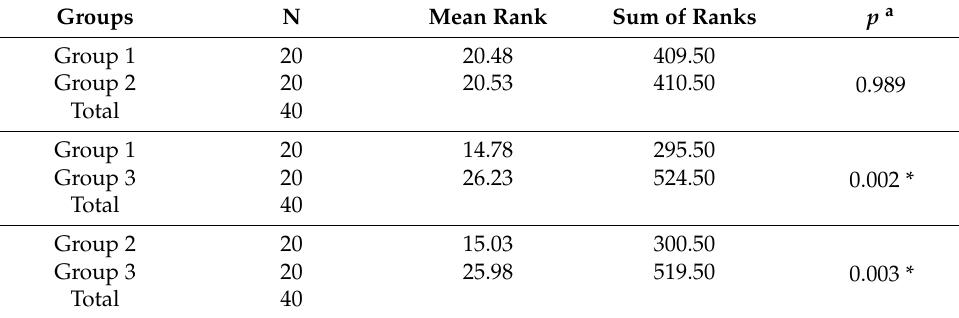
Table 3. Pairwise comparison results of the groups in the